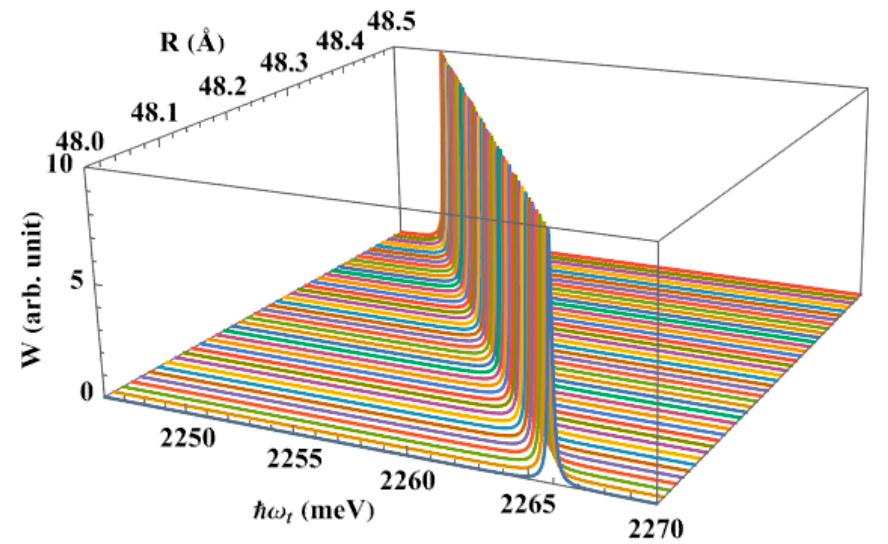
Figure 4. The interband absorption spectra as a function of dot radius, with the apical angle θ 0 = 60 ◦ , in the absence of the pump laser.